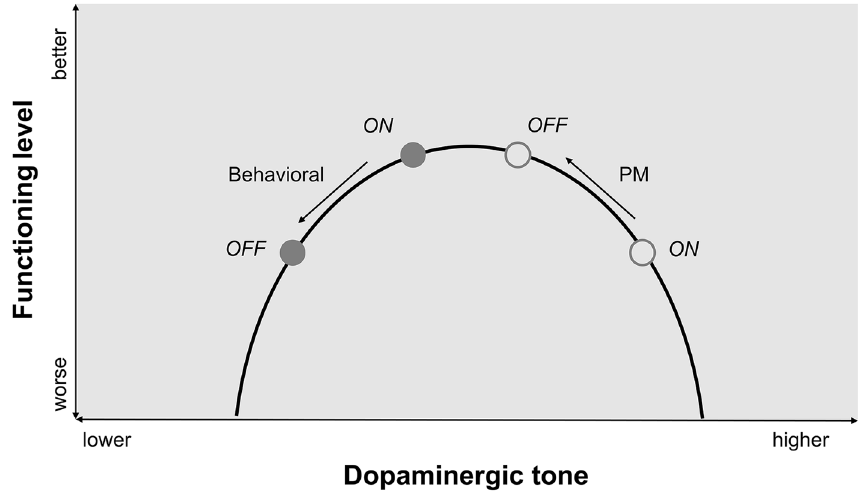
Figure 5. Relation between dopaminergic tone and functioning. U-shaped curve for the proposed relation between dopaminergic tone and behavioral and pupillometric (PM) functioning. While behavioral performance degrades in OFF state, pupil responses normalize in OFF state compared to healthy controls 45,46